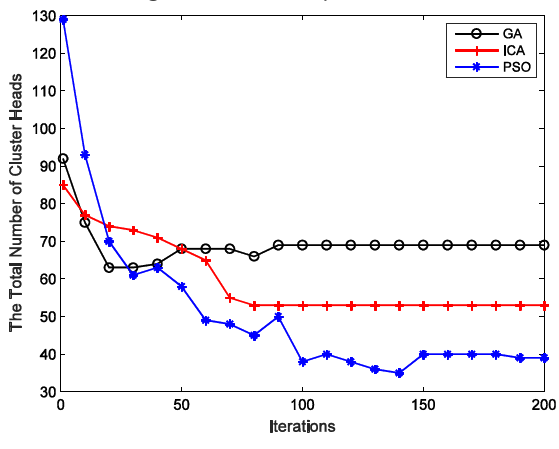
Figure 7. Total number of CHS per iterations.